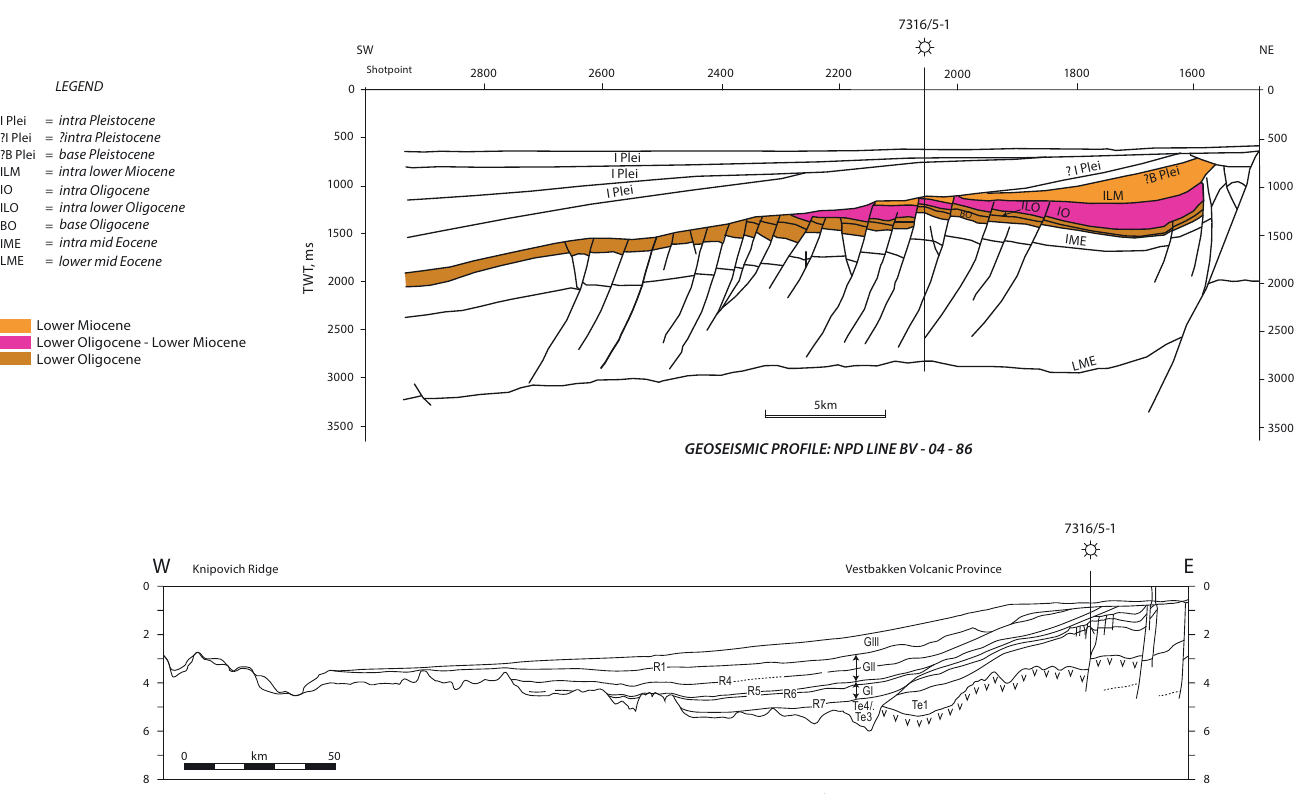
Figure 28. The lower profile shows a regional geoseismic line across the Bjørnøya Fan through well 7316/5–1 (modified after Faleide et al., 1996). R1 to R7 = regional reflectors and GI to GIII = seismic units (according to Faleide et al., 1996). Te1, Te3 and Te4 = seismic units (according to Vorren et al., 1991). The upper profile shows details across the Vestbakken Volcanic Province (modified after Eidvin et al., 1998b). Location in Fig.